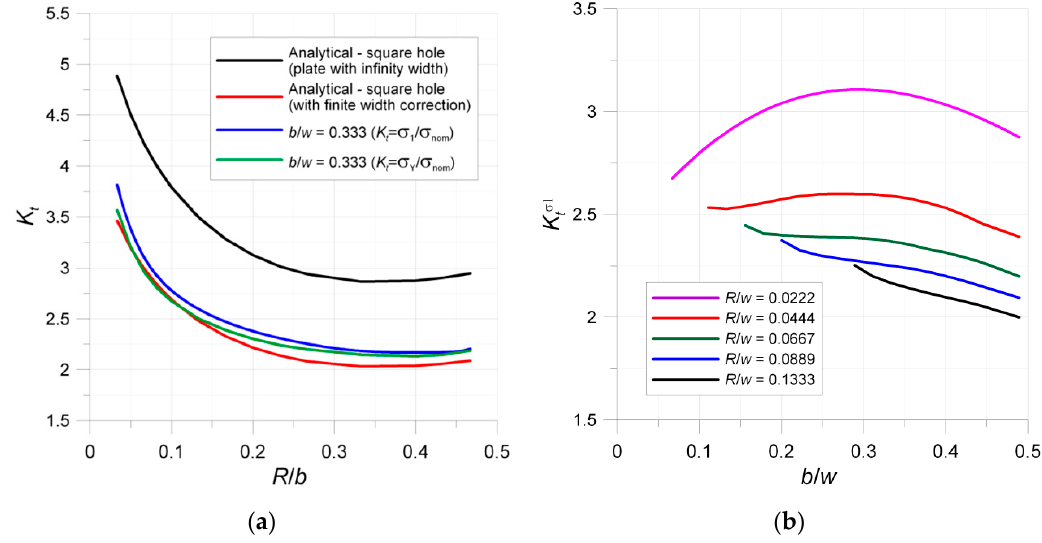
Figure 5. Analytically and numerically (FEM—ANSYS) calculated SCF for panels with square holes ( a = b ) with rounded corners subjected to in-plane tension: ( a ) influence of fillet radius—ratio R / b for constant b / w ; and ( b ) influence of hole size (ratio b / w ) and radius of rounded corner (ratio R / w ) on stress concentration factor.